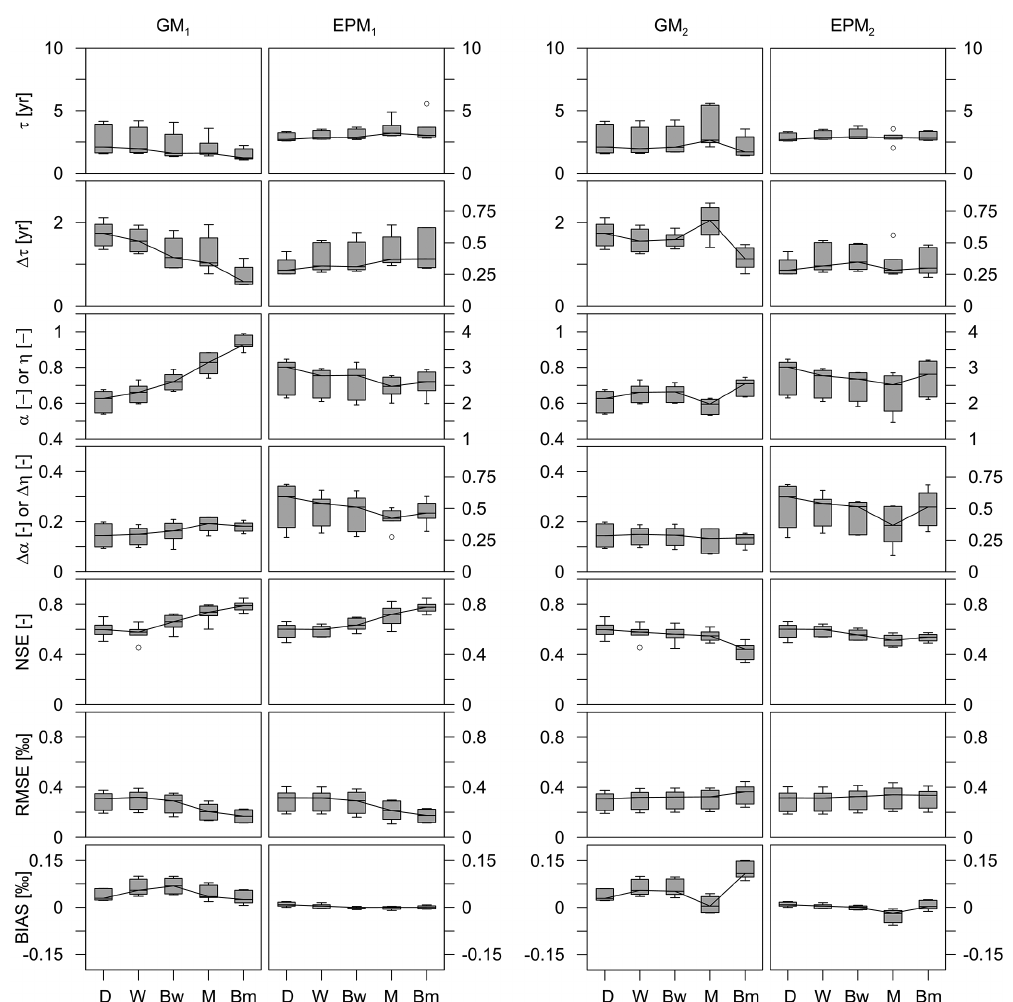
Figure 4. Comparison of predictions for stream water sites using the gamma (GM) and exponential-piston (EPM) lumped models. The subscript in the model name stands for the type of scenario: Sc1 is aggregation of sampling frequency in the rainfall and also in the effluent, Sc2 is aggregation of sampling frequency only in rainfall data. Acronyms in the x axis of all plots stands for five types of data resolution: D is daily, W is weekly; Bw is bi-weekly, M is monthly and Bm is bi-monthly. Box plots markers correspond to quartiles and median values are shown (–). The length of whiskers is limited to 1.5 times the width of the box and values located further away below the first quartile or above the third quartile are considered extreme ones ( ◦